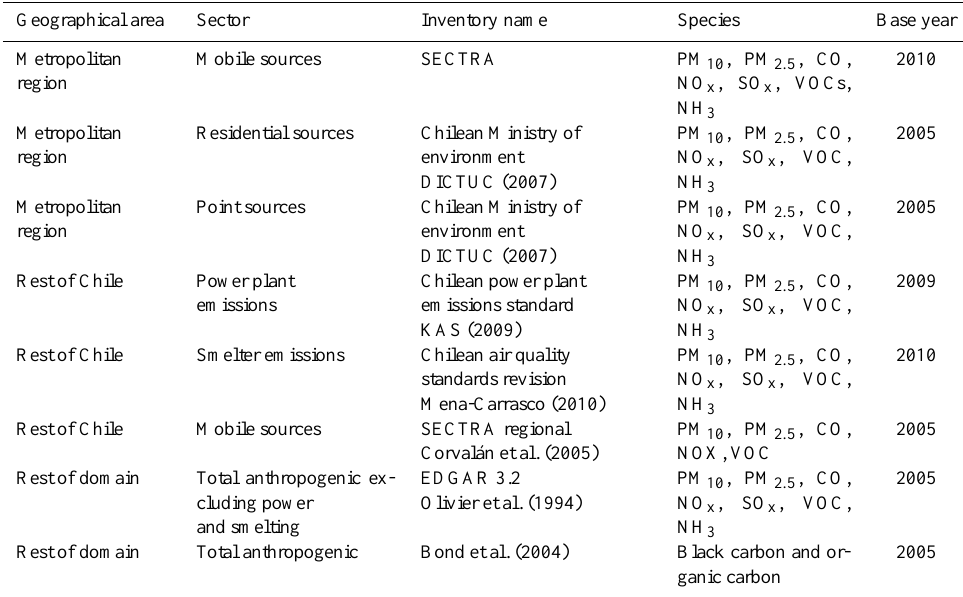
Table 1. Summary of emissions inventories configurations. Areas are divided in metropolitan region, which is located on Central Chile, the rest of Chile and the rest of the